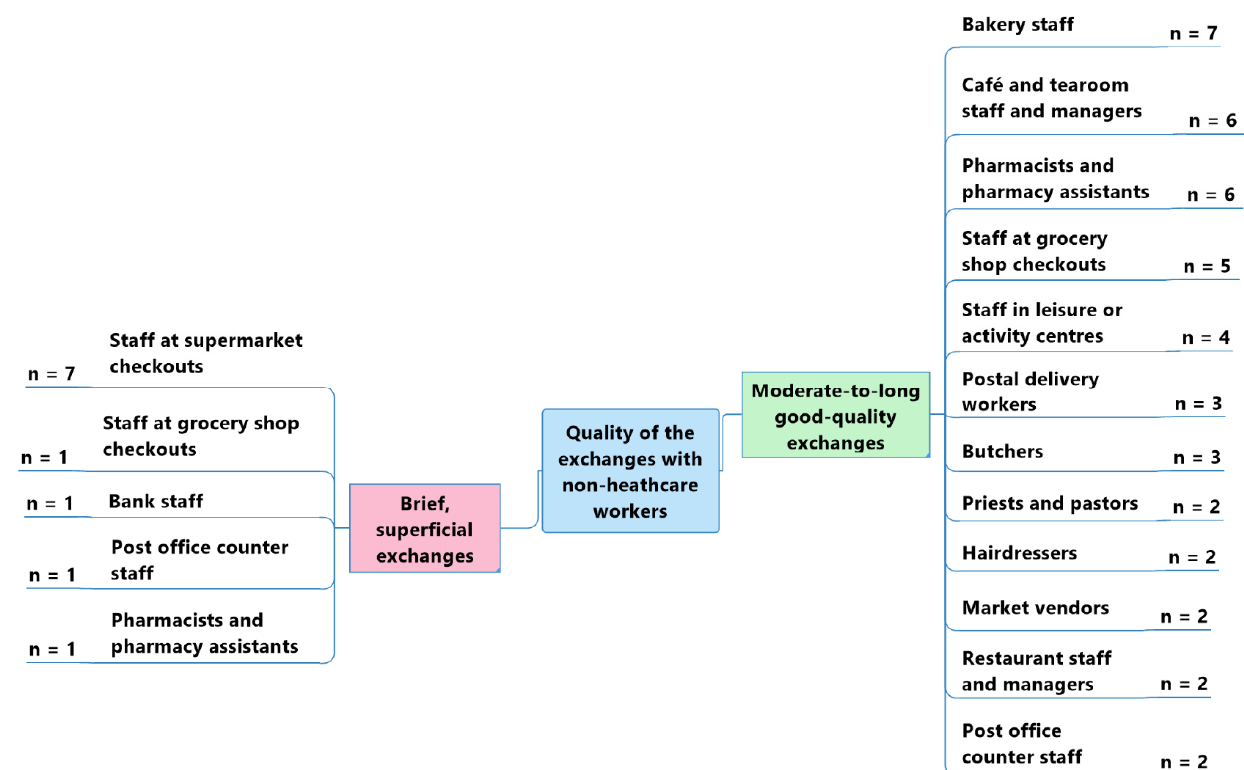
Figure 5. Perceived quality of the exchanges between participants without self-reported cognitive impairments and non-healthcare workers.